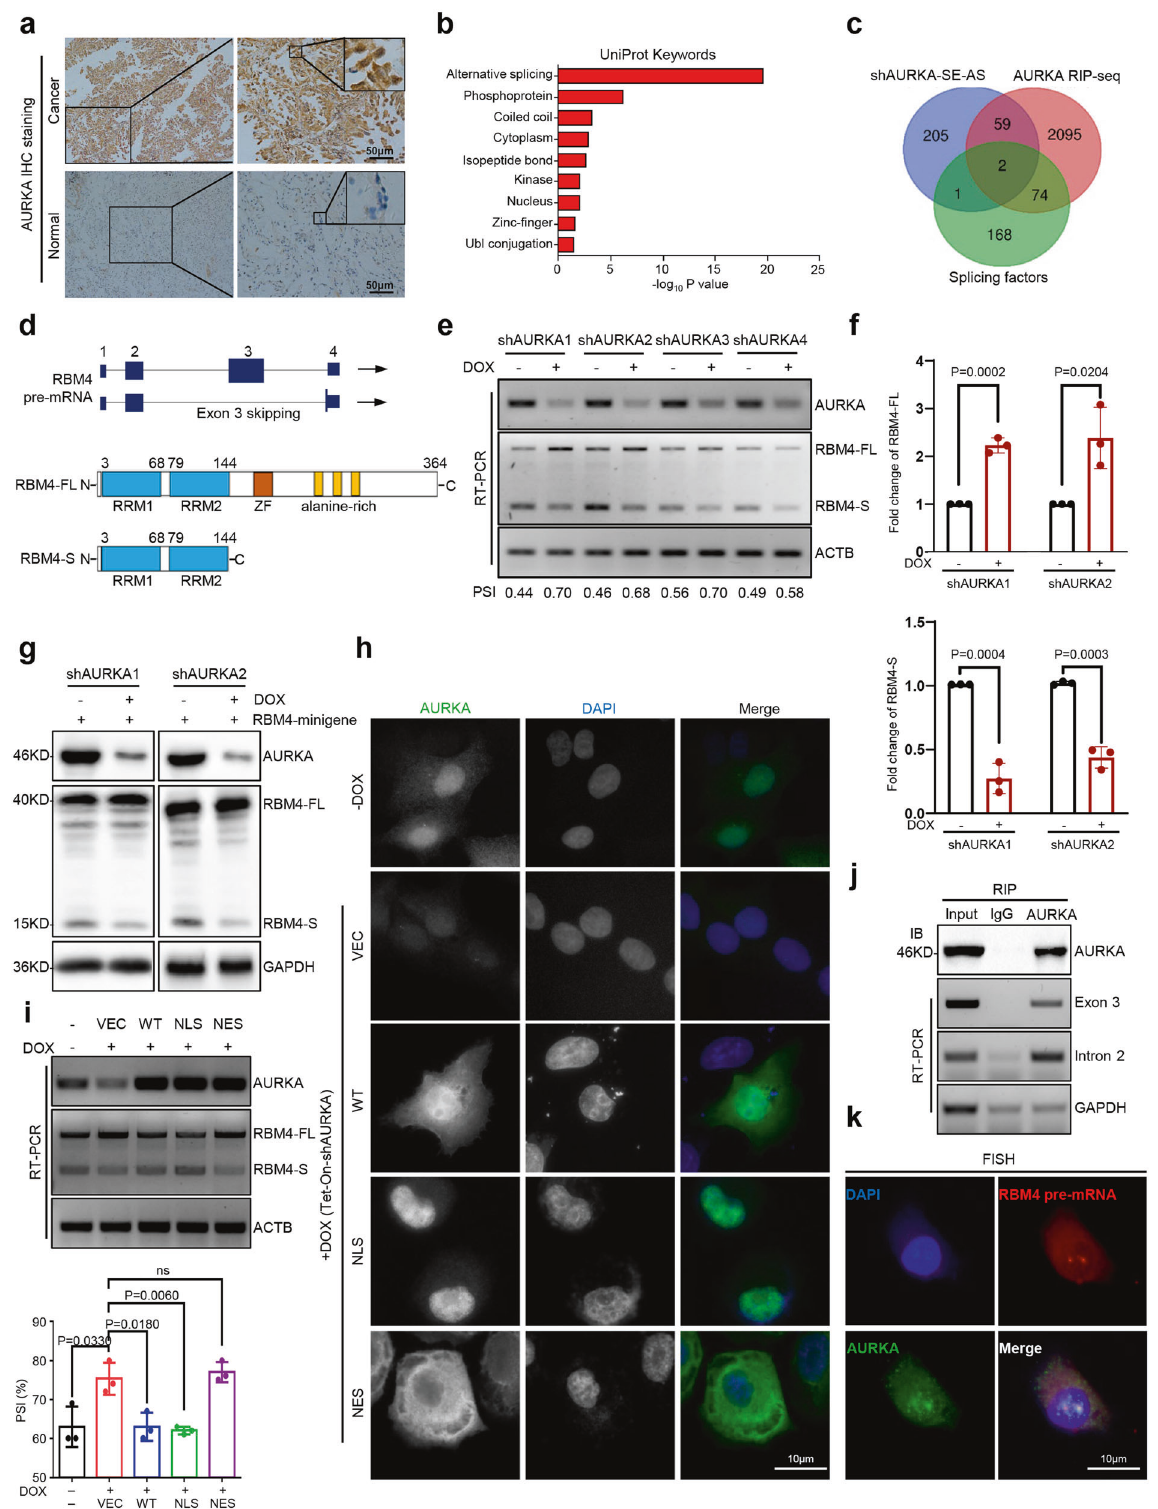
expression had no effect on the splicing inhibitory activity of RBM4-FL (Supplementary Fig. S5a – b). Our previous studies have demonstrated that the anticancer activity of RBM4 depends not only on its splicing regulatory function but also on its antagonized effect on the expression of oncogenic SRSF1 protein. 19